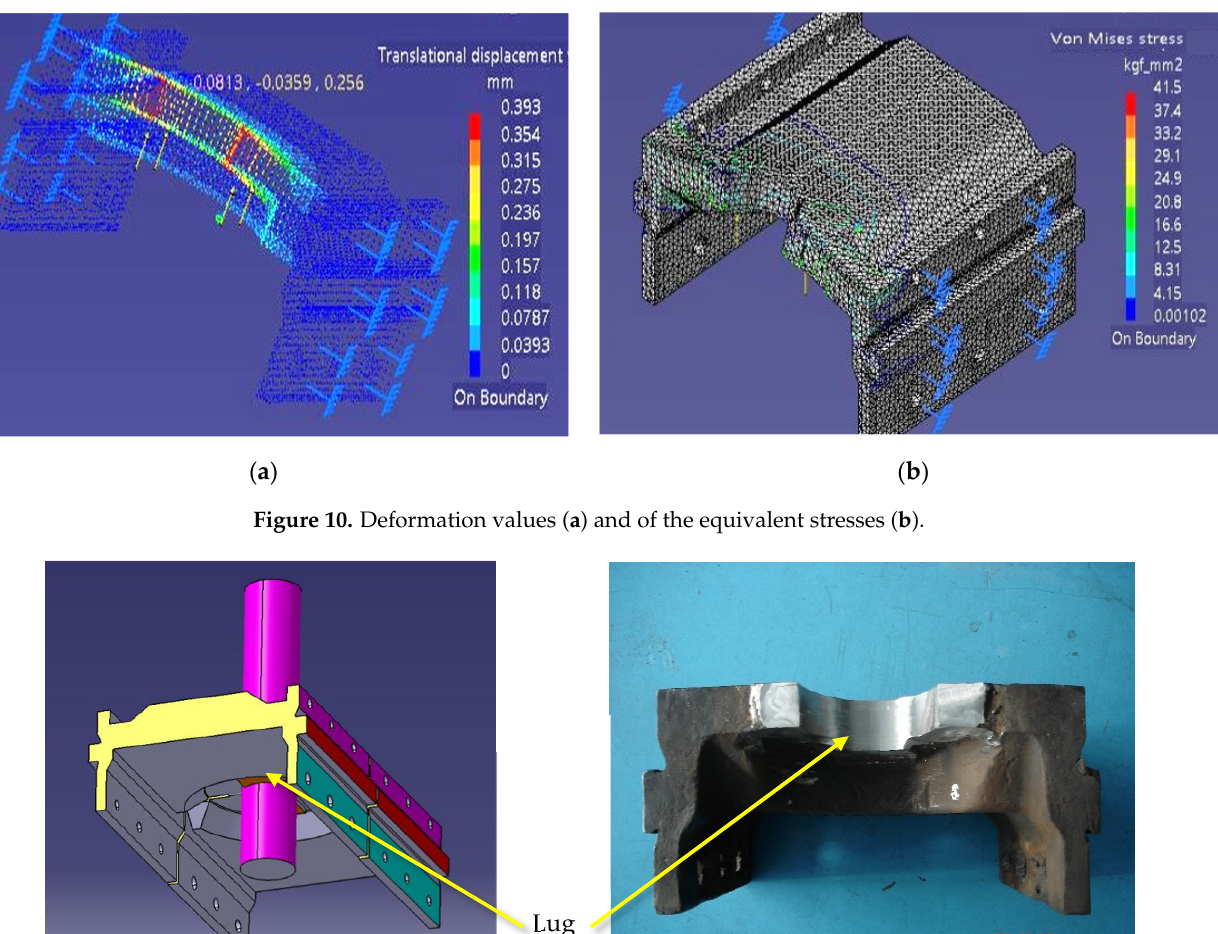
Figure 9. The loads and restrictions imposed on the trimming die for FEM modeling: ( a )—undeformed trimming die; ( b )— deformed trimming die.